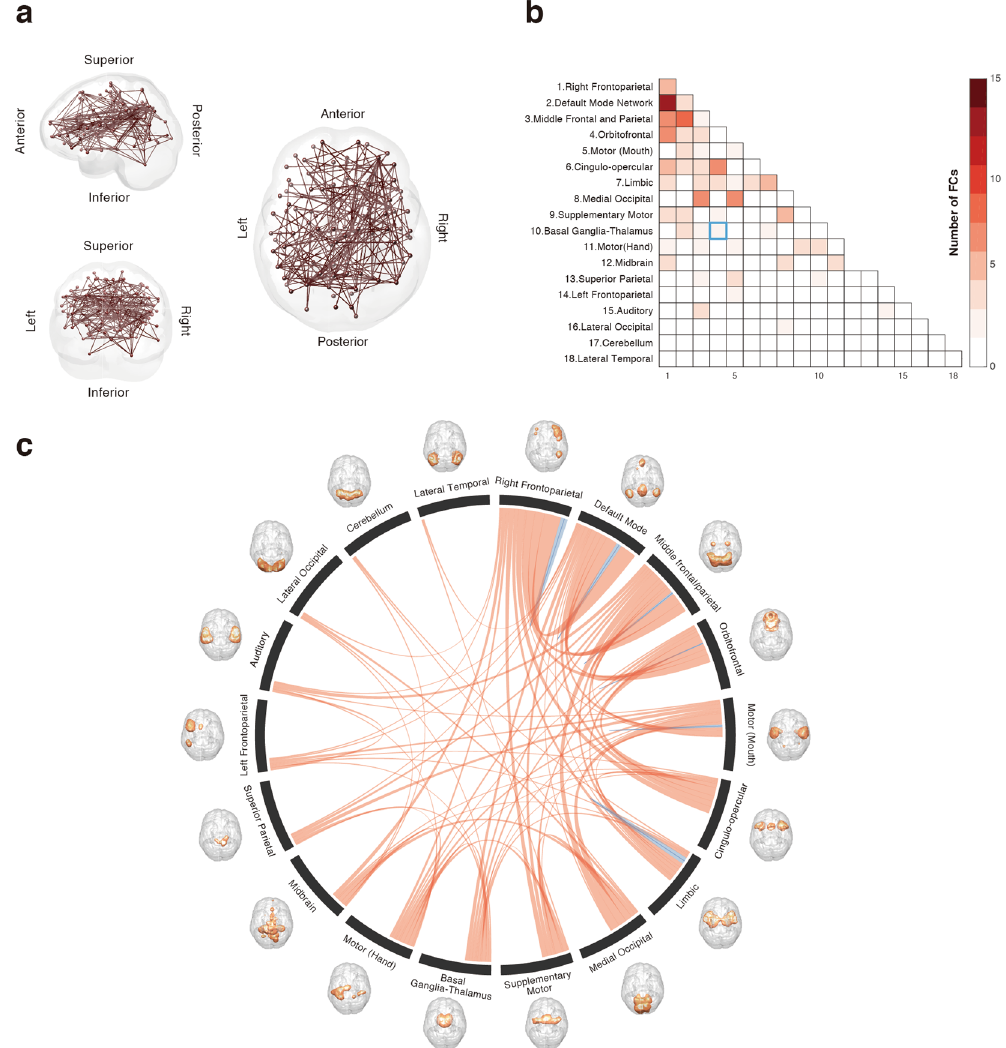
Figure 3. Functional connections used in the classification of the OCD and HC populations. ( a ) The 200 most contributing FCs from the left (left top), posterior (left bottom), and top (right) to the WLSs are visualized. ( b ) Matrices for the most contributing 200 FCs in 18 macroscale regions that were functionally defined in a previous study 35 . Diagonal and non-diagonal elements show within- and between-network FCs, respectively. The blue box highlights the corresponding area in the matrix discussed in the main text, i.e., FC between the orbitofrontal and basal ganglia-thalamus networks. The color bar indicates the number of FCs included between two networks. ( c ) Circle plot of the 200 most contributing 200 FCs in 18 macroscale regions. The number of FCs in each of the 2 macroscale regions is presented as the thickness of the connection lines (edges). The connections within the same network are colored blue, and connections between two different networks are colored